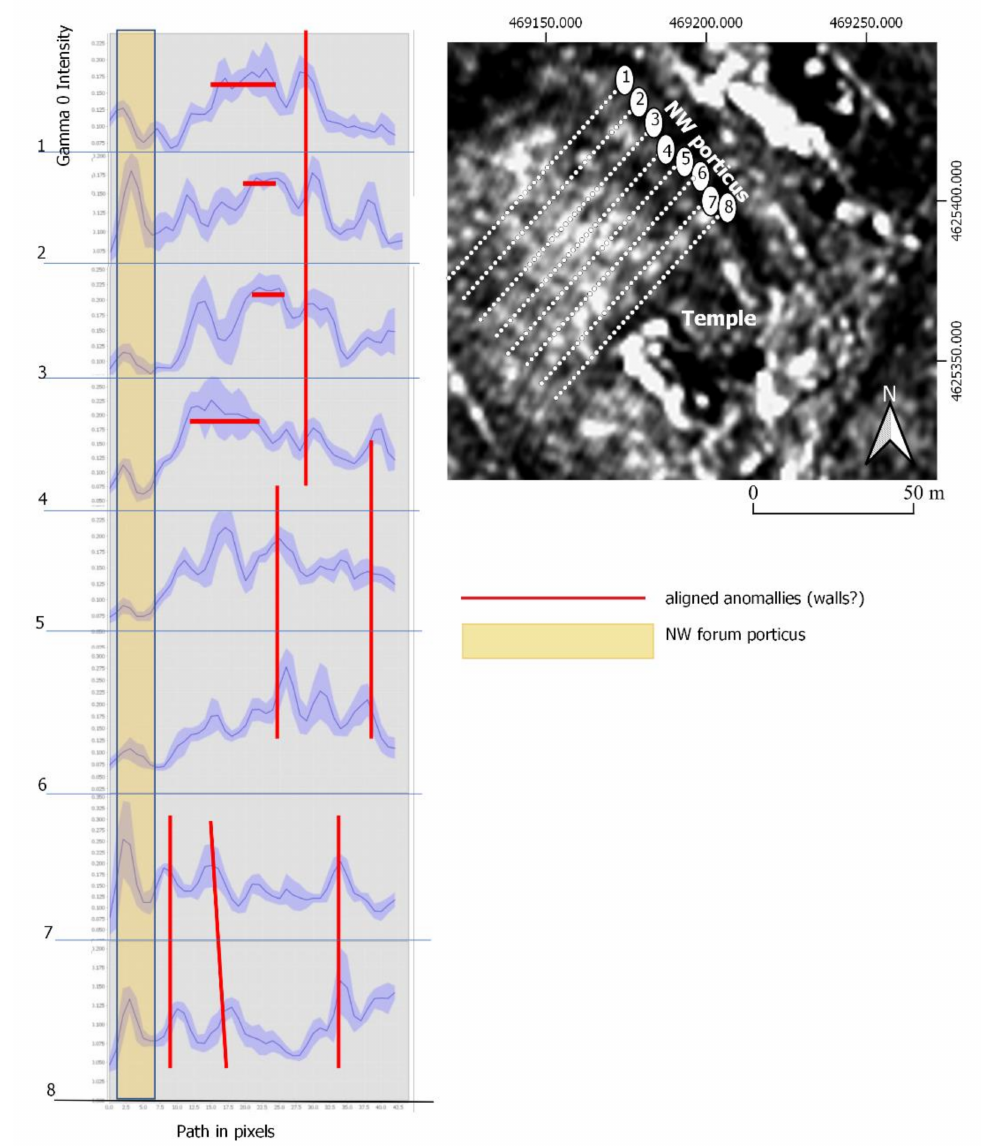
Figure 11. Profiles of eight samples taken from the multi-temporal SAR-X PAZ radar image. The red lines are indicating a repetition rate of reading the signal, and, therefore, the presence of aligned